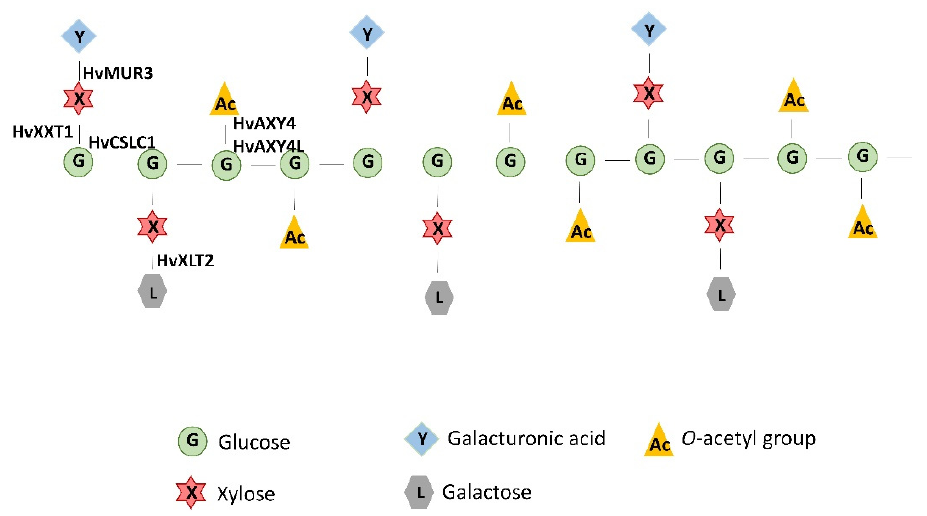
Figure 9. The scheme of XyG type occurring in barley root hair during tube elongation and the proteins potentially involved in its synthesis. HvCSLC1—cellulose synthase-like C1, HvXXT1—xyloglucan 6-xylosyltransferase, HvMUR3, HvXLT2—galactosyltransferases, HvAXY4—altered xyloglucan 4, HvAXY4L—altered xyloglucan 4-like.